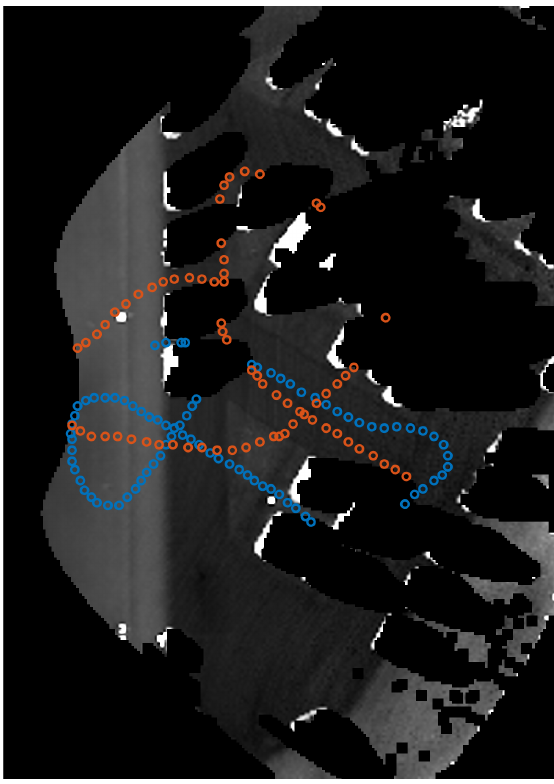
Figure 7. Example of laser-based pedestrian tracking (reference trajectories in Figure 2).